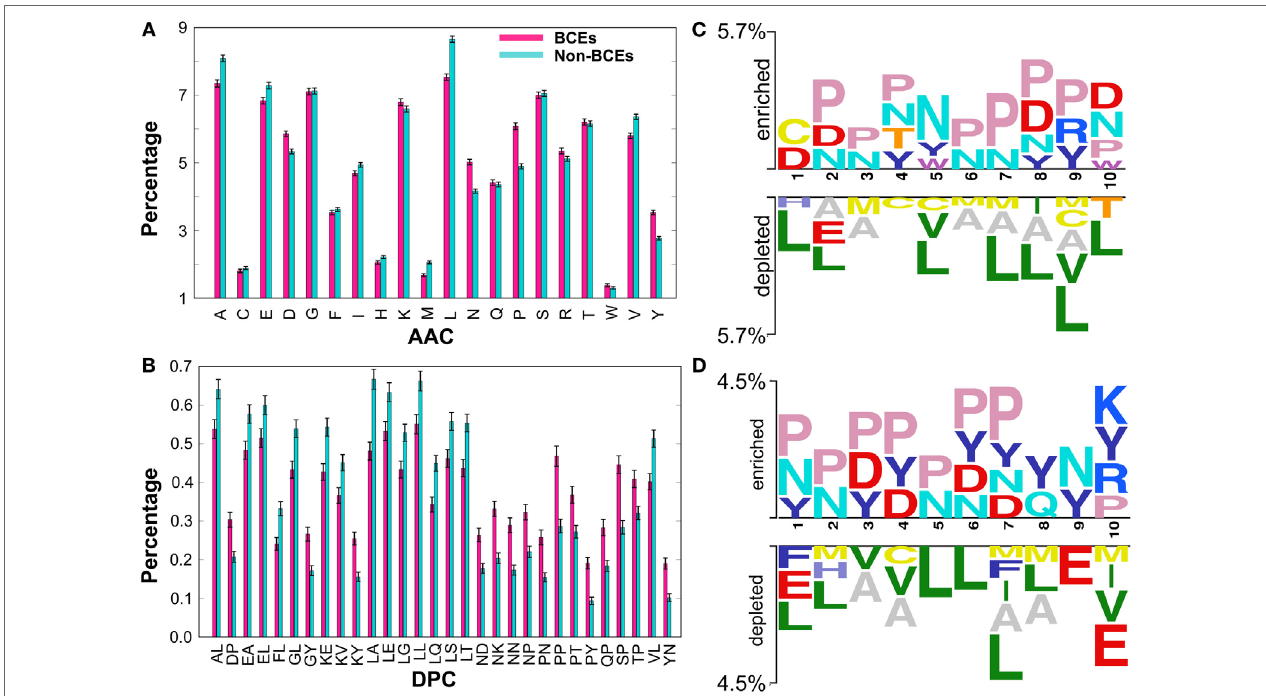
FIGURe 2 | Compositional and positional preference analysis. (A) and (B) respectively represent the amino acid and dipeptide preferences of BCEs and non-BCEs. (B) Shows significant differences in top 30 dipeptides. (C,d) Represent positional conservation of 10 residues at the N- and C-terminals, respectively, between BCEs and non-BCEs, generated using two sample logos. In (A,B) , error bar is the SE that indicates the reliability of the mean. A smaller SE indicates that the sample mean is more accurate reflection of the actual population